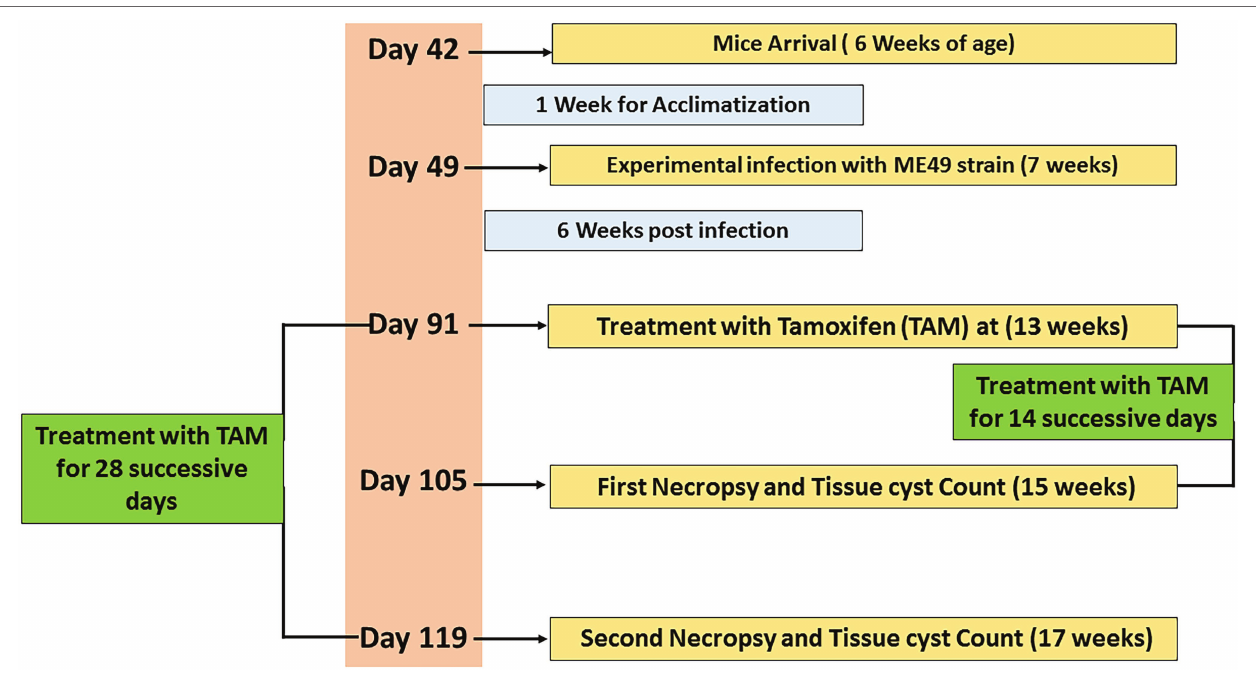
FIGURE 1 | Timeline of the experimental protocol explaining the day (D) number, treatments, and